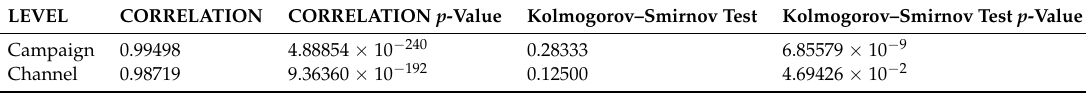
Table A5. This table shows the correlation and Kolmogorov–Smirnov test for Figure